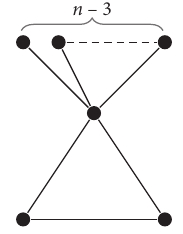
Figure 8: The unicyclic graph S 1